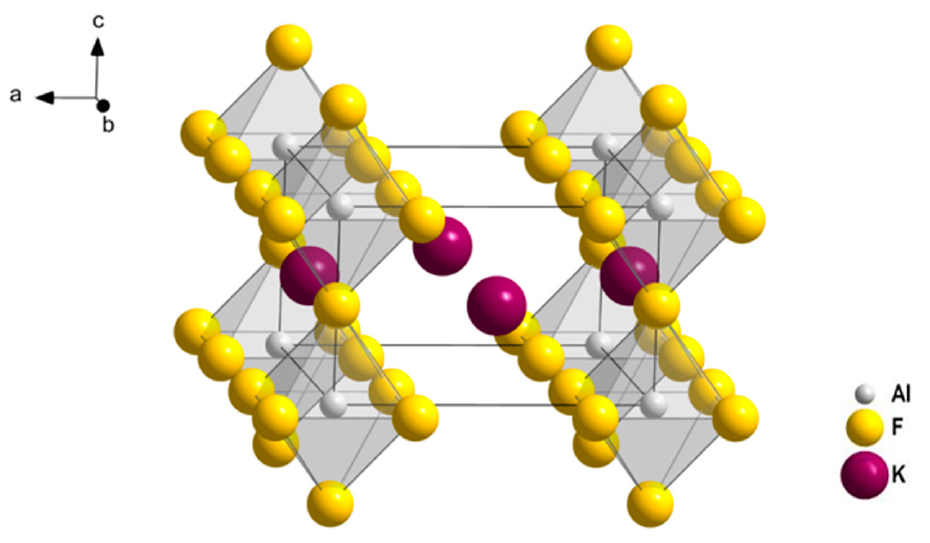
Figure 5. Section of the crystal structure of K 2 AlF 5 -1 according to [13]. The five different potassium sites in K 2 AlF 5 -3 are coordinated by nine, ten, or eleven fluoride ions (see Figure 6). In contrast to K 2 AlF 5 -2, the coordination by the octahedra of the chains is only realized mono- or three-dentate, but no bi-dentate coordination appears. Each site connects three chains of AlF 6 -octahedra, similar to the situation in K 2 AlF 5 -2 (see Figure 7). Still, internal distances in both modifications are rather similar: d (Al–F) in K 2 AlF 5 -3 to terminal fluoride ligands range from 176 pm to 180 pm, while those to bridging fluoride ions are longer with 191 and 192 pm (Table 5). Again the internal angles within the octahedra are close to ideal the of 90 ◦ and 180 ◦ , while the angles at the bridging